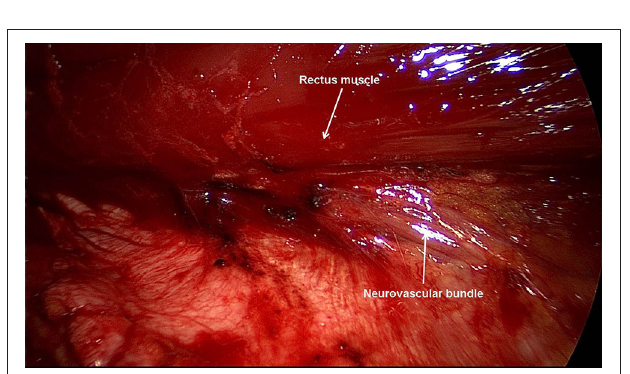
FIGURE 5 | The retromuscular plane can be extended cephalad to the retroxiphoid and retrosternal areas. Typical finding before transection of the right and left posterior rectus sheath.